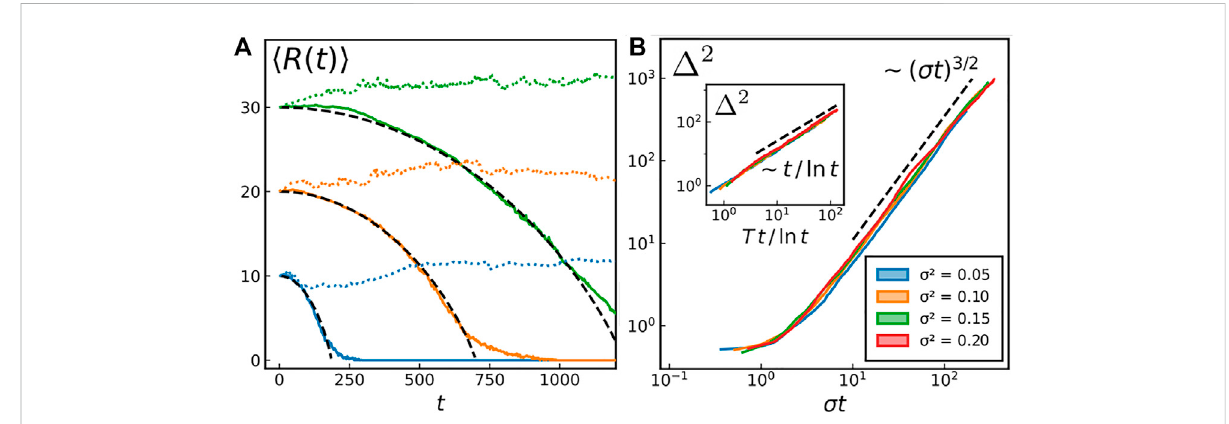
FIGURE 6 (A) Vortex-antivortex separation, averaged over 120 independent runs, for three different initial vortex-antivortex distances R 0 (blue: R 0 = 10, orange: R 0 =20andgreen: R 0 =30).Fullcoloredlinescorrespondto T =0.1and σ 2 =0.Dottedcoloredlinescorrespondto T =0.1and σ 2 =0.1.Black dashed lines are the predictions for an overdamped dynamics with a Coulomb interaction potential Eq. 11. (B) Mean square displacement